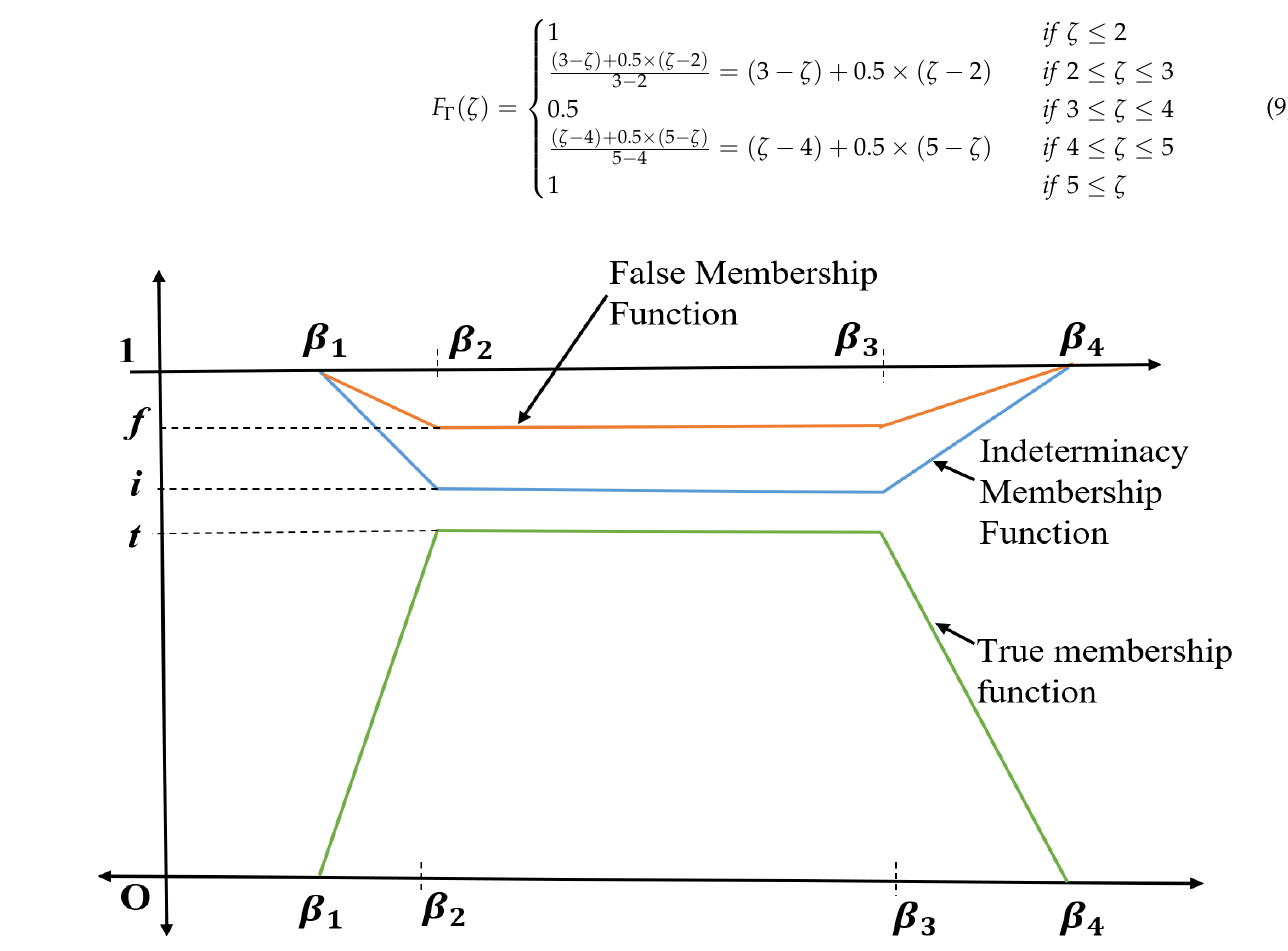
Figure 2. Geometric representation of trapezoidal neutrosophic number